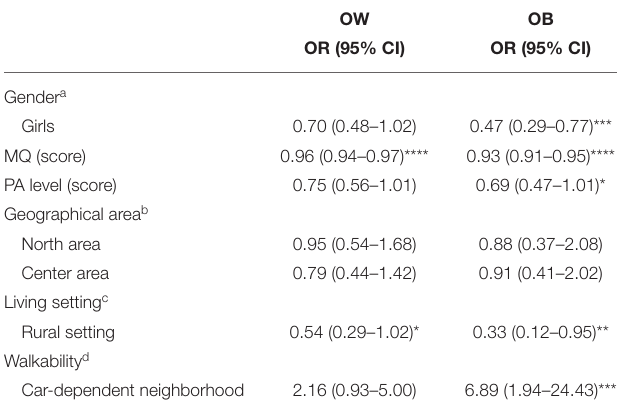
TABLE 2 | Multinomial logistic regression predicting BMI